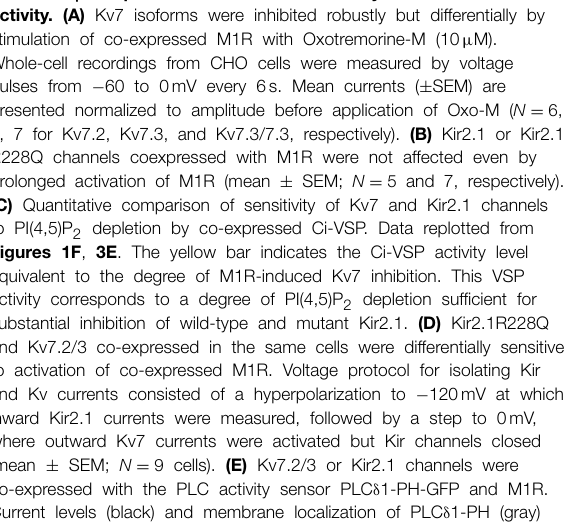
FIGURE 5 | Comparison of channel sensitivity to VSP and to PLC activity. (A) Kv7 isoforms were inhibited robustly but differentially by stimulation of co-expressed M1R with Oxotremorine-M (10 µ M). Whole-cell recordings from CHO cells were measured by voltage pulses from − 60 to 0mV every 6s. Mean currents ( ± SEM) are presented normalized to amplitude before application of Oxo-M ( N = 6 , 5, 7 for Kv7.2, Kv7.3, and Kv7.3/7.3, respectively). (B) Kir2.1 or Kir2.1 R228Q channels coexpressed with M1R were not affected even by prolonged activation of M1R (mean ± SEM; N = 5 and 7, respectively). (C) Quantitative comparison of sensitivity of Kv7 and Kir2.1 channels to PI(4,5)P 2 depletion by co-expressed Ci-VSP. Data replotted from Figures 1F , 3E . The yellow bar indicates the Ci-VSP activity level equivalent to the degree of M1R-induced Kv7 inhibition. This VSP activity corresponds to a degree of PI(4,5)P 2 depletion sufficient for substantial inhibition of wild-type and mutant Kir2.1. (D) Kir2.1R228Q and Kv7.2/3 co-expressed in the same cells were differentially sensitive to activation of co-expressed M1R. Voltage protocol for isolating Kir and Kv currents consisted of a hyperpolarization to − 120mV at which inward Kir2.1 currents were measured, followed by a step to 0mV, where outward Kv7 currents were activated but Kir channels closed (mean ± SEM; N = 9 cells). (E) Kv7.2/3 or Kir2.1 channels were co-expressed with the PLC activity sensor PLC δ 1-PH-GFP and M1R. Current levels (black) and membrane localization of PLC δ 1-PH (gray)